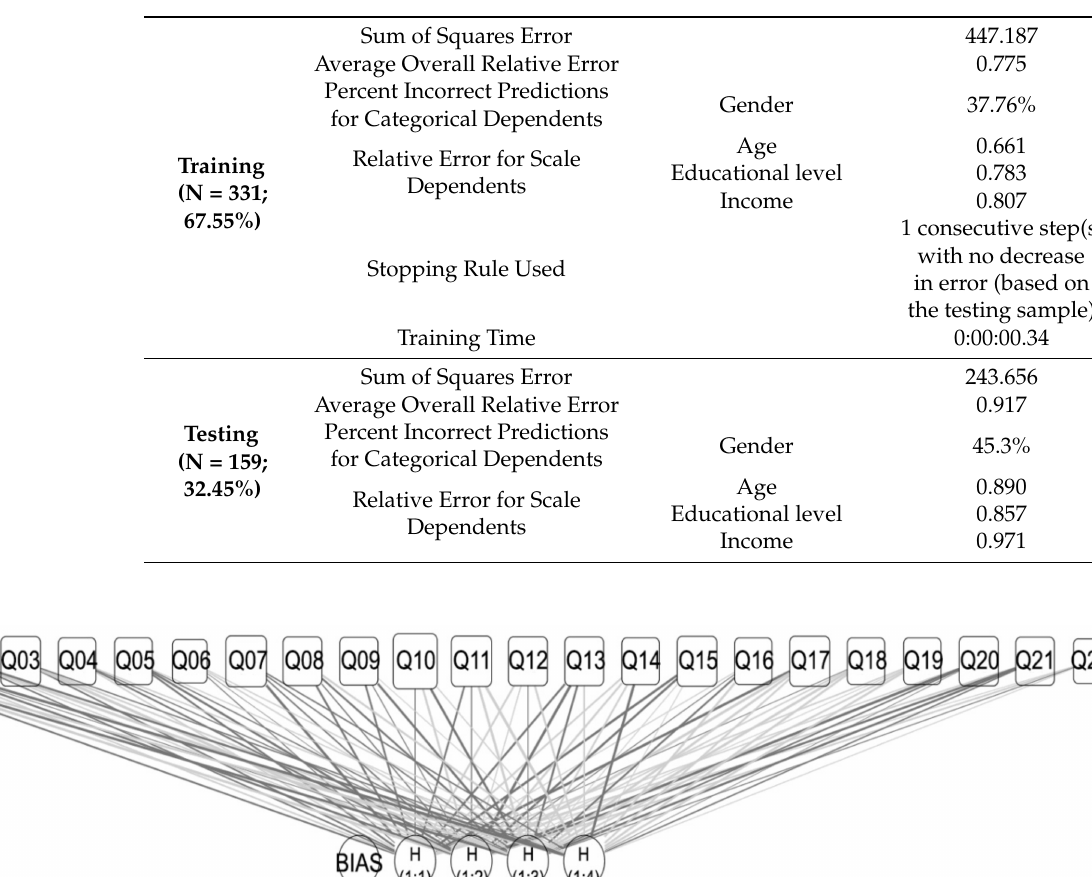
Table 4. Model summary.